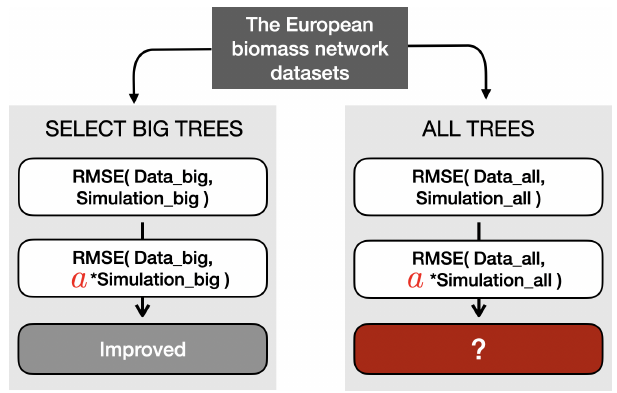
Figure 9. Schematic representation of the verification process for the RMSE metric. Before the verification, two types of datasets were prepared: big-tree data (limited to the 15% biggest trees) and all-tree data. In this example, the simulated TRW was multiplied with a verified modifier such that it minimized the RMSE between the simulated and observed TRW for the 15% biggest trees (see Sect. 3.2 for details). The same multiplier was then applied to the all-tree data, and the RMSE was calculated. Finally, the decrease or increase in RMSE with the multiplier was compared to the RMSE obtained without the multiplier. The other two modifiers, which are detailed in Sect. 3.3, follow a similar